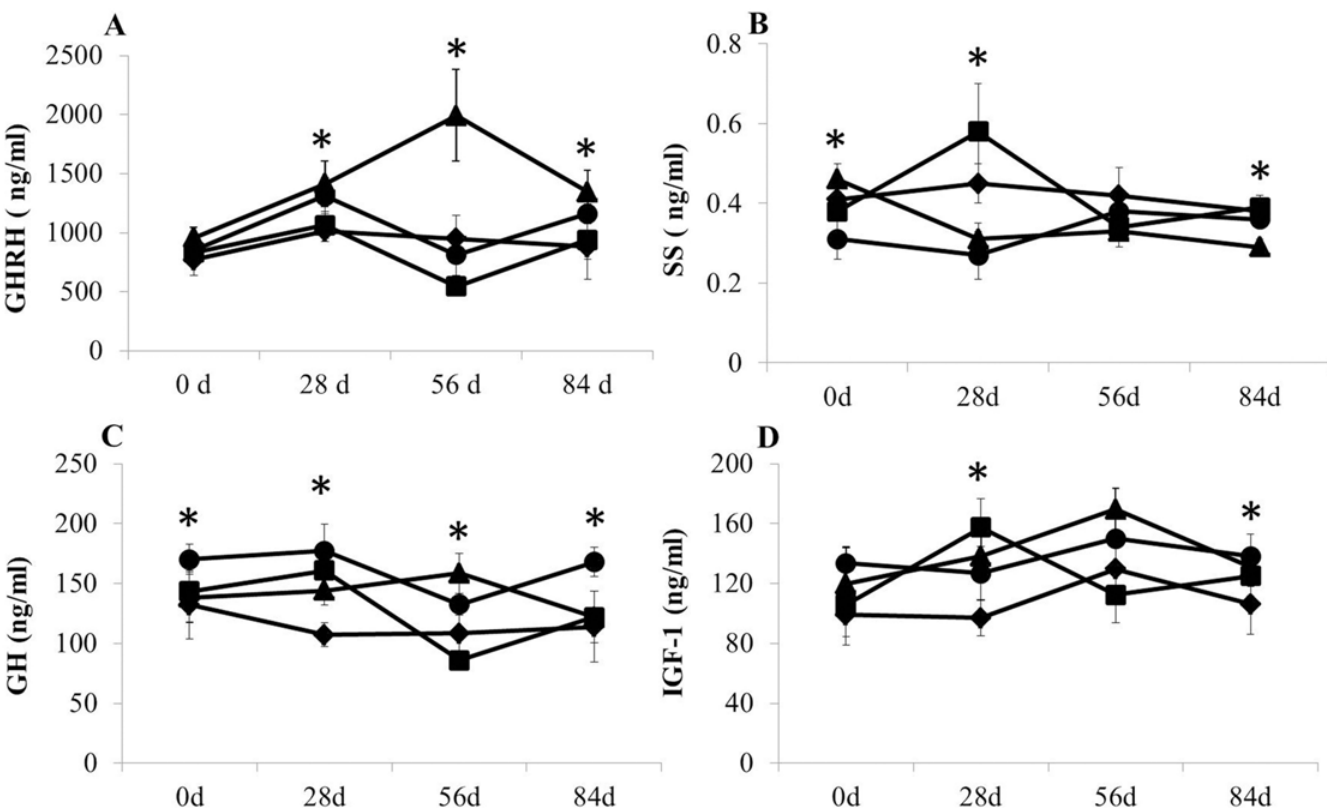
Fig 2. Effects of GHRP-2 and CS on serum hormone levels in yaks with growth retardation A is the serum GHRH levels; B is the serum SS levels; C is the serum GH levels; D is the serum IGF-1 levels; Rhombus: negative control group (yaks with growth retardation being fed basic rations); Square: GHRP-2 injection group (yaks with growth retardation being fed basic rations and GHRP-2 injection on days 1 – 6, 11 – 16, and 21 – 26); Triangle: CS feeding group (yaks with growth retardation being fed basic rations and supplementary fed cysteamine on days 1 – 28); Roundness: positive control group (yaks with normal growth feeding basic ration); “ * ” indicates significant differences ( P <